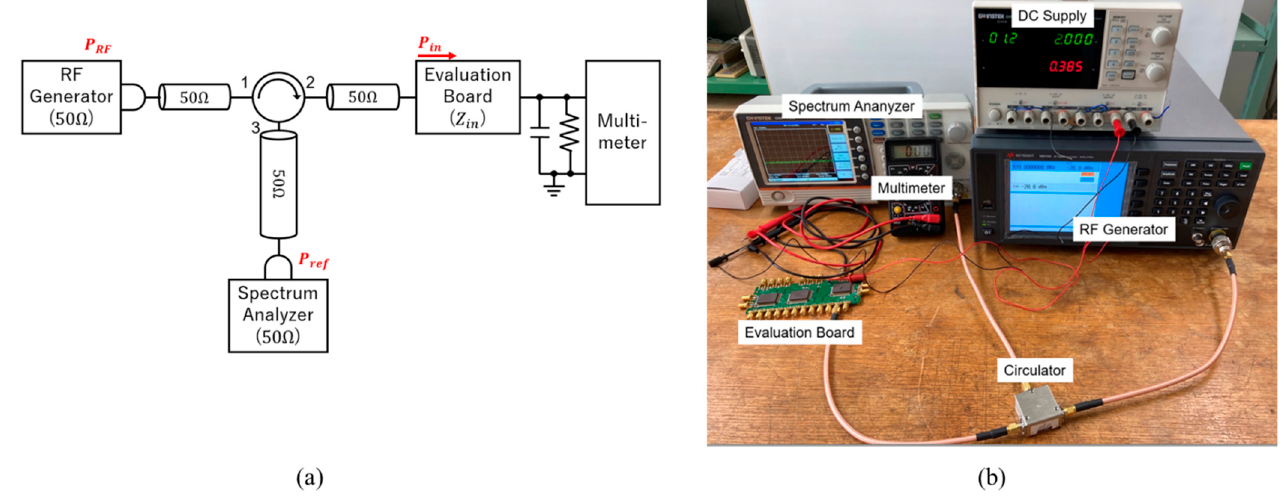
Figure 11. Block diagram of measurement setup ( a ) and its photo ( b ).